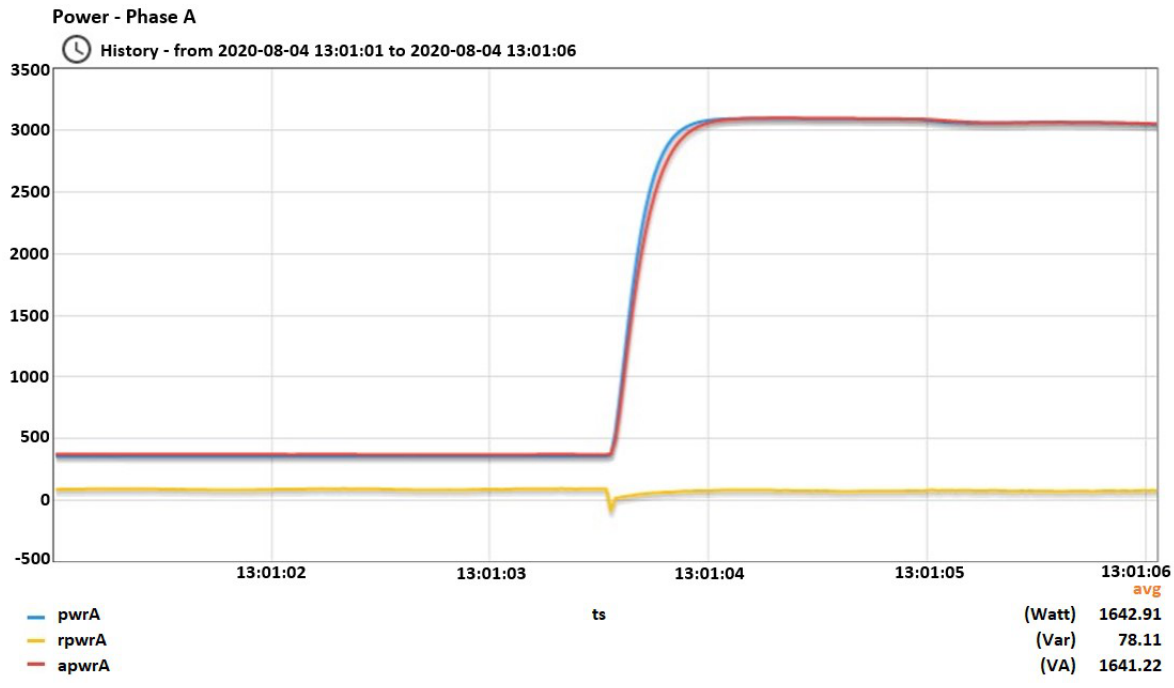
Figure 11. Oven’s